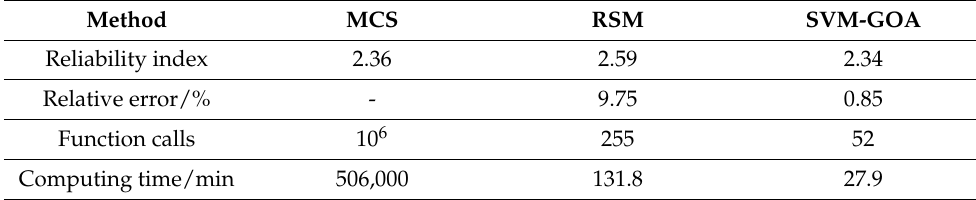
Table 11. Comparison of calculation